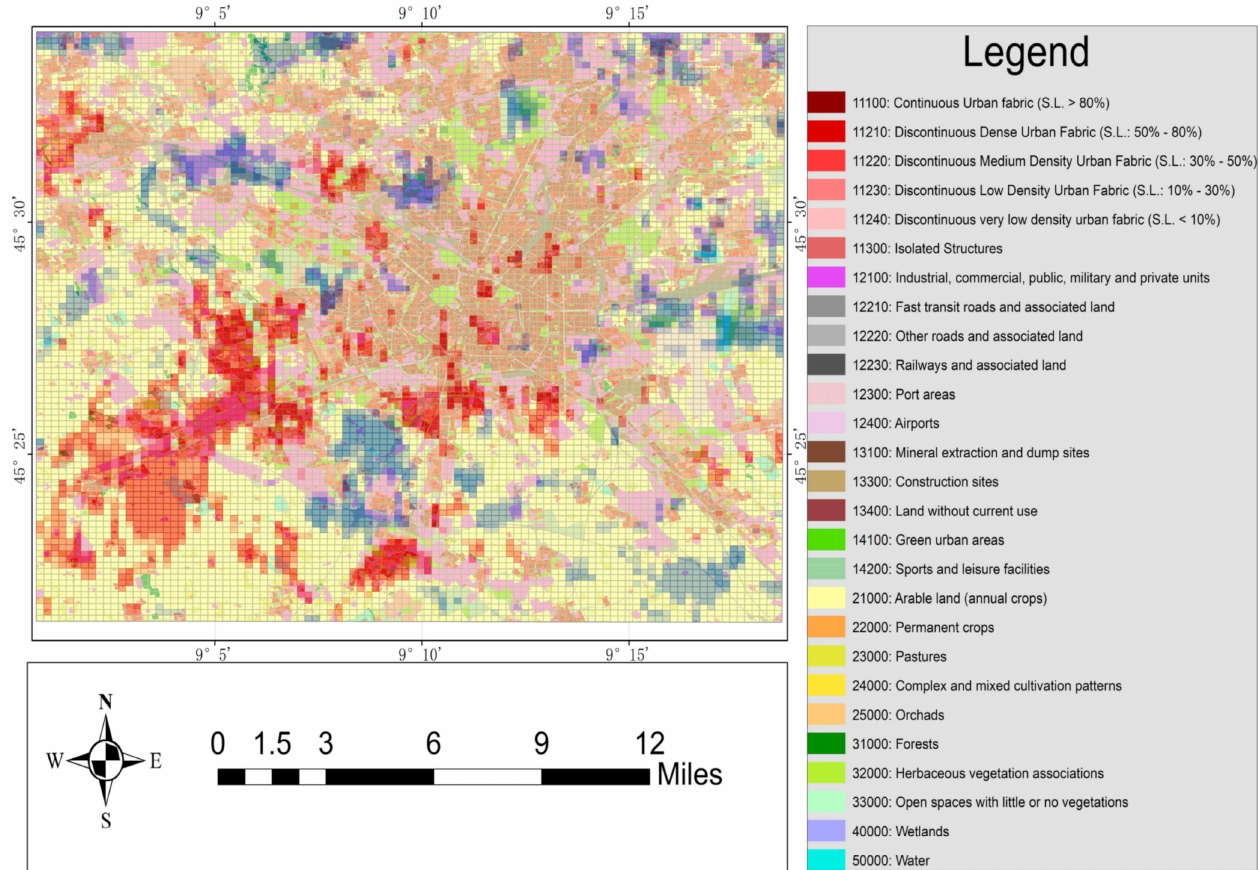
Figure 14. Map overlay of the detected hot/cold spots with the land-use dataset. However, the relationship through spatial visualization analysis between the hot/cold regions and geographic features obtained was not accurate enough, so the authors further conducted a quantitative statistical analysis. The quantitative statistical analysis included two comparisons: quantity distribution comparison and ratio distribution